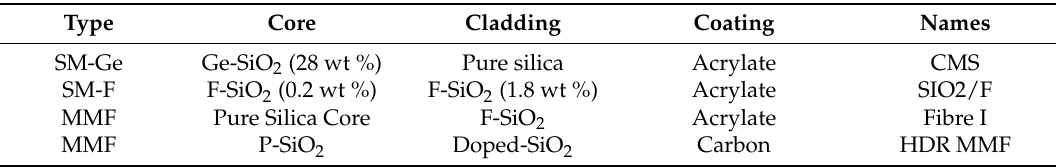
Table 3. Optical fibers selected for the ANDRA qualification